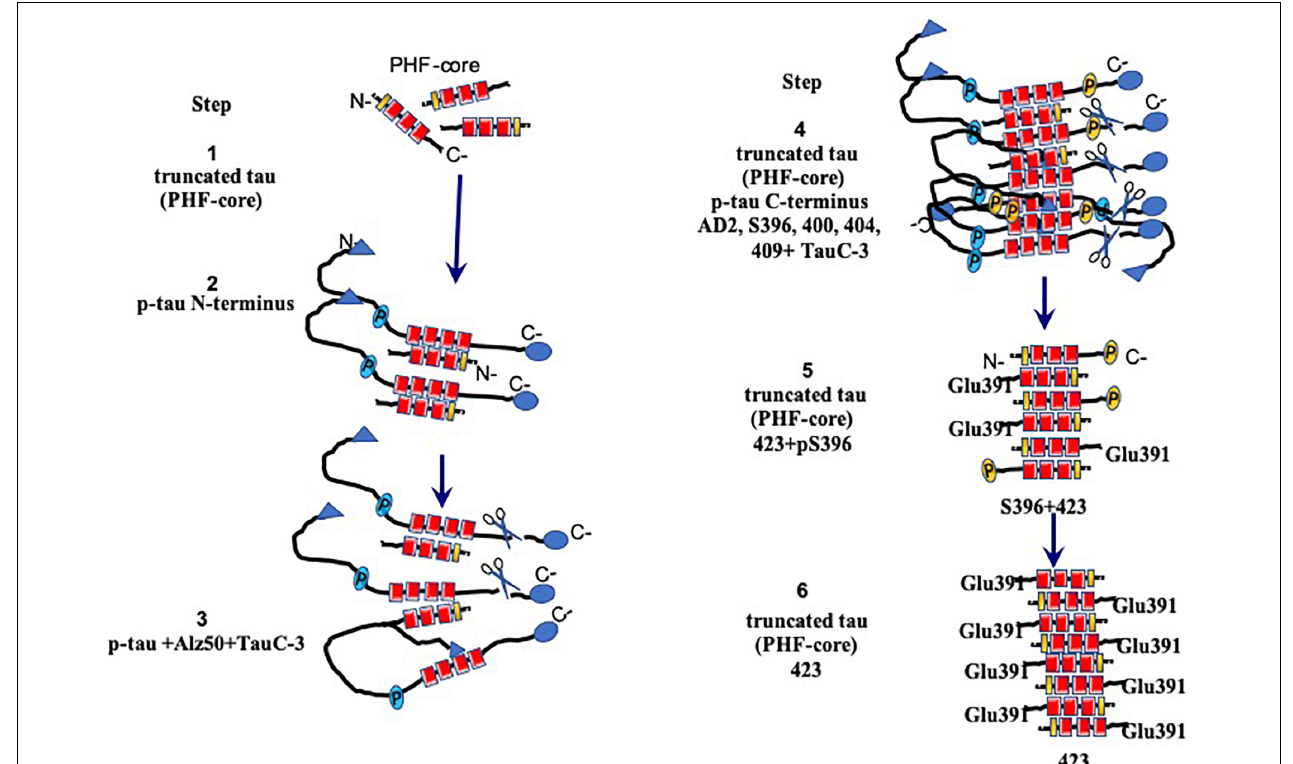
FIGURE 7 | Model for the assembly and processing of tau proteins in paired helical filaments (PHFs). Neurons that have not yet been affected express the intact tau protein associated mainly with microtubules in axons. Braak stages I–IV are the early stages prior to fibrillary inclusions. Stages I and II represent the presence of a PHF core (circa 95-amino acid residue fragment). Stage III is characterized by the cytoplasmic aggregation of the tau molecules, favored by the nuclear fragments of tau. PHFs begin their formation with intact and tau molecules phosphorylated in the N-terminus. This stage corresponds to the presence of the granular tau protein in the neuronal cytoplasm seen by confocal microscopy. The PHF core is masked by intact and phosphorylated tau molecules. In stage IV, the truncation between the amino acids Asp-421/Ser-422 appears. This truncation is observed from the granular stages. In stage V, intracellular PHFs and fibrils are initiated, phosphorylated in both their N- and C-terminal portions, which are recognized with antibody 423 (Glu-391 truncation). The fibrillar nature is confirmed by the affinity of the thiazine red (TR) dye in stage VI. The N-terminal portions are removed. As the neurofibrillary tangle (NFT) becomes extracellular, the structures are highly insoluble and are exclusively immunoreactive with antibody 423, with only occasional epitopes of pS396 available.